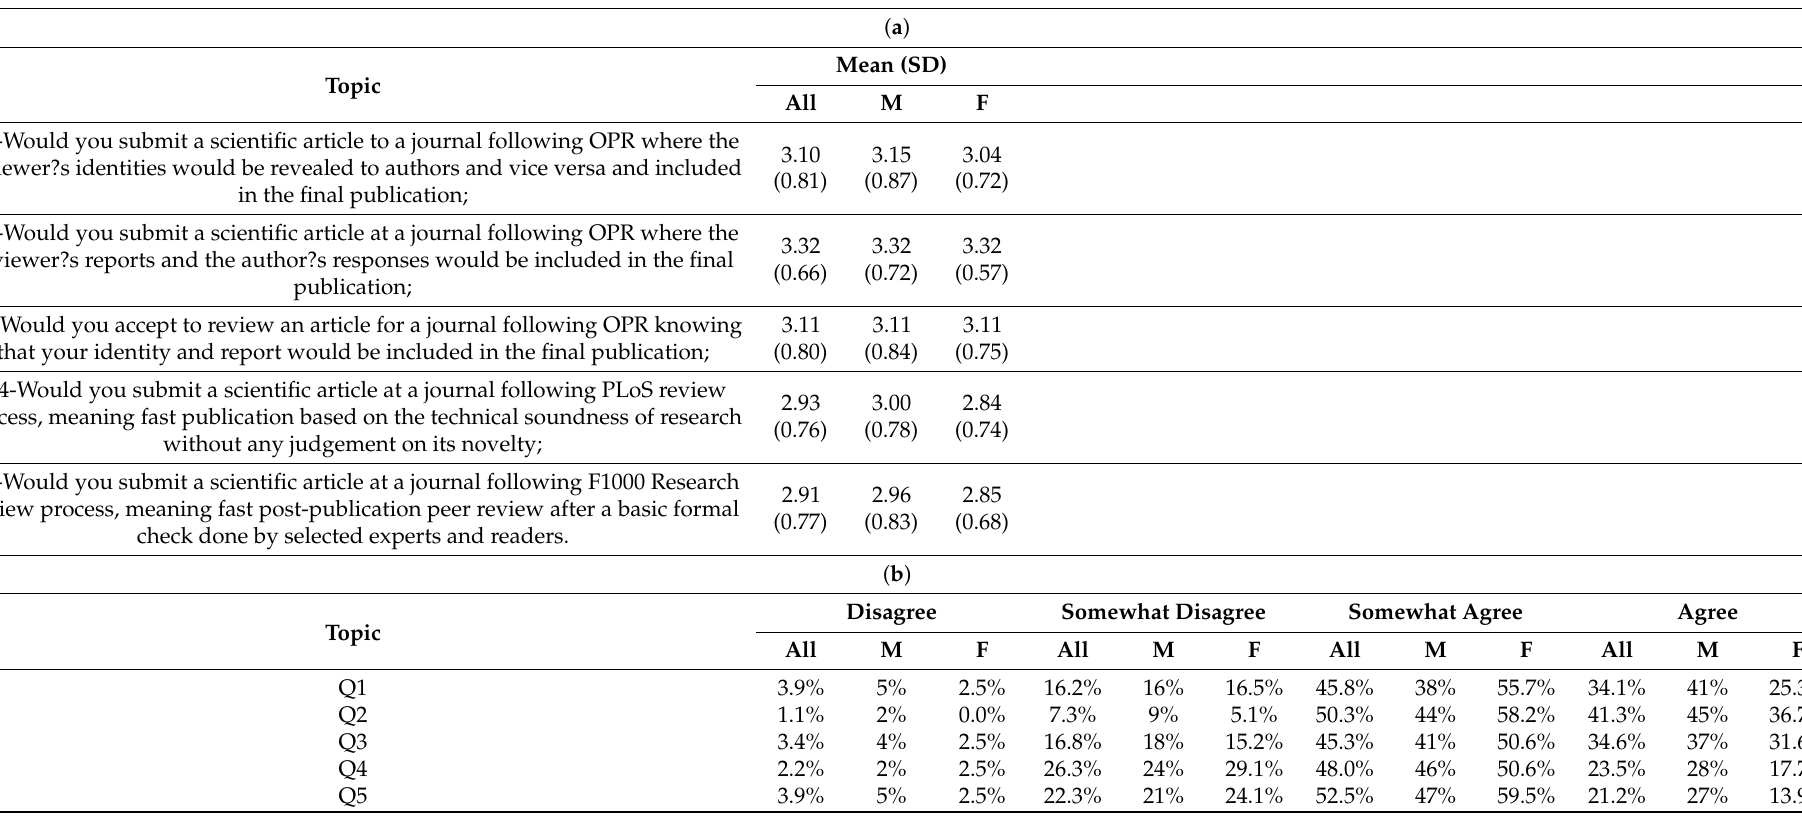
Table 6. ( a ) Define your position regarding Open Peer Review potentials-Mean and Standard Deviation per topic (Part 3, Q1 to Q5, All-Male–Female). ( b ) Define your position regarding Open Peer Review potentials-Percentages per topic (Part 3, Q1 to Q5,